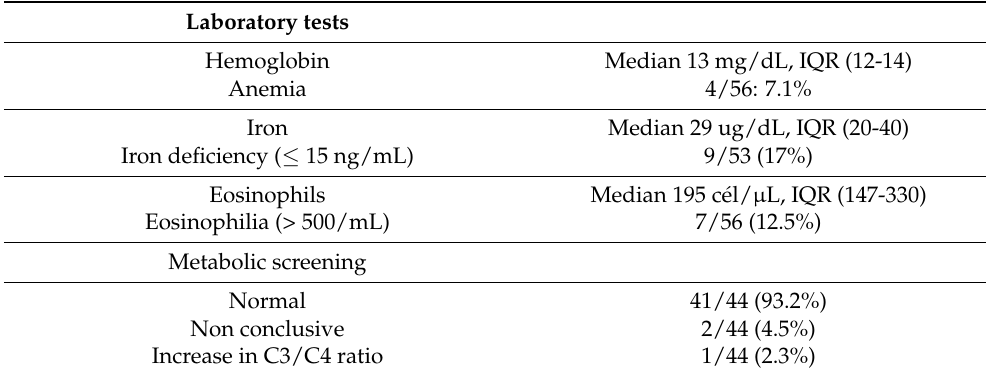
Table 3. Complementary blood tests performed after first visit upon